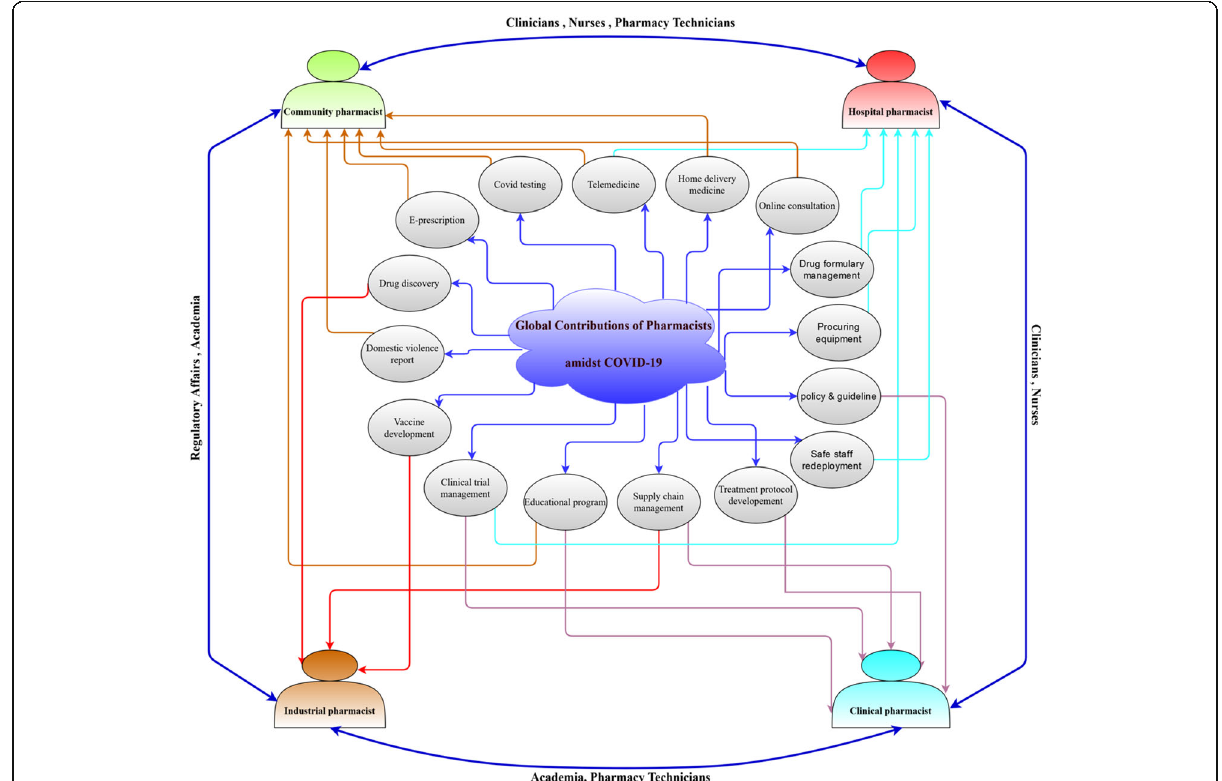
Fig. 1 Overview of global contributions of pharmacists amidst